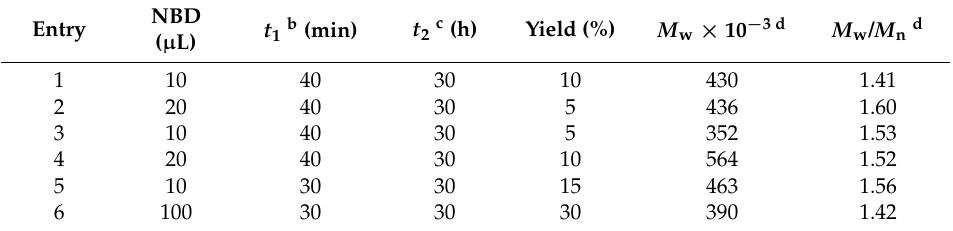
Table 5. Formulations and results of the “arm-first” method at {W 2 }/NBE molar ratio 1/500 in CH 2 Cl 2 a .